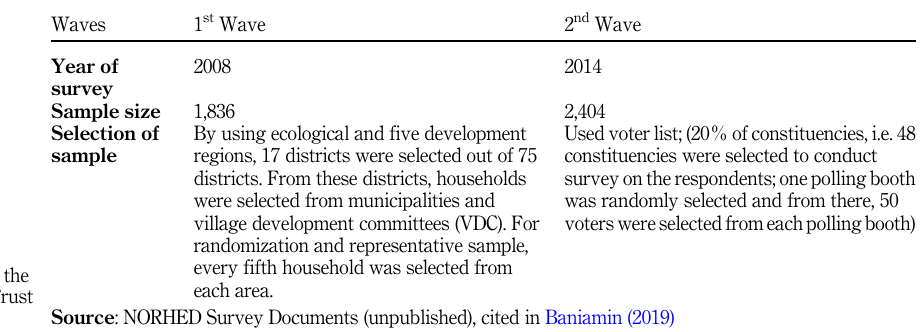
Governance and Trust Survey in